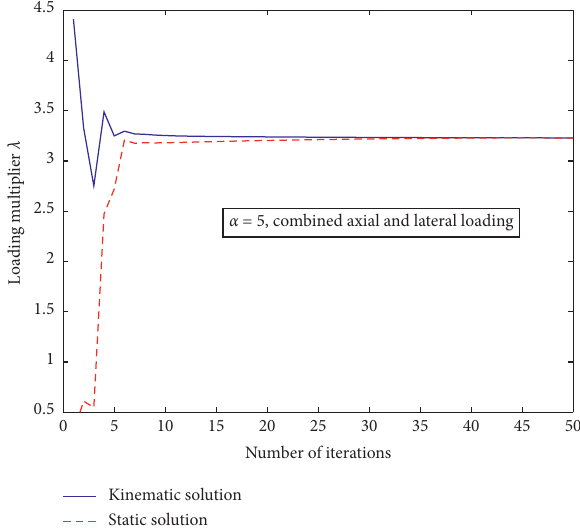
Figure 6: Variations of the kinematic and the static loading multipliers for α � 0.